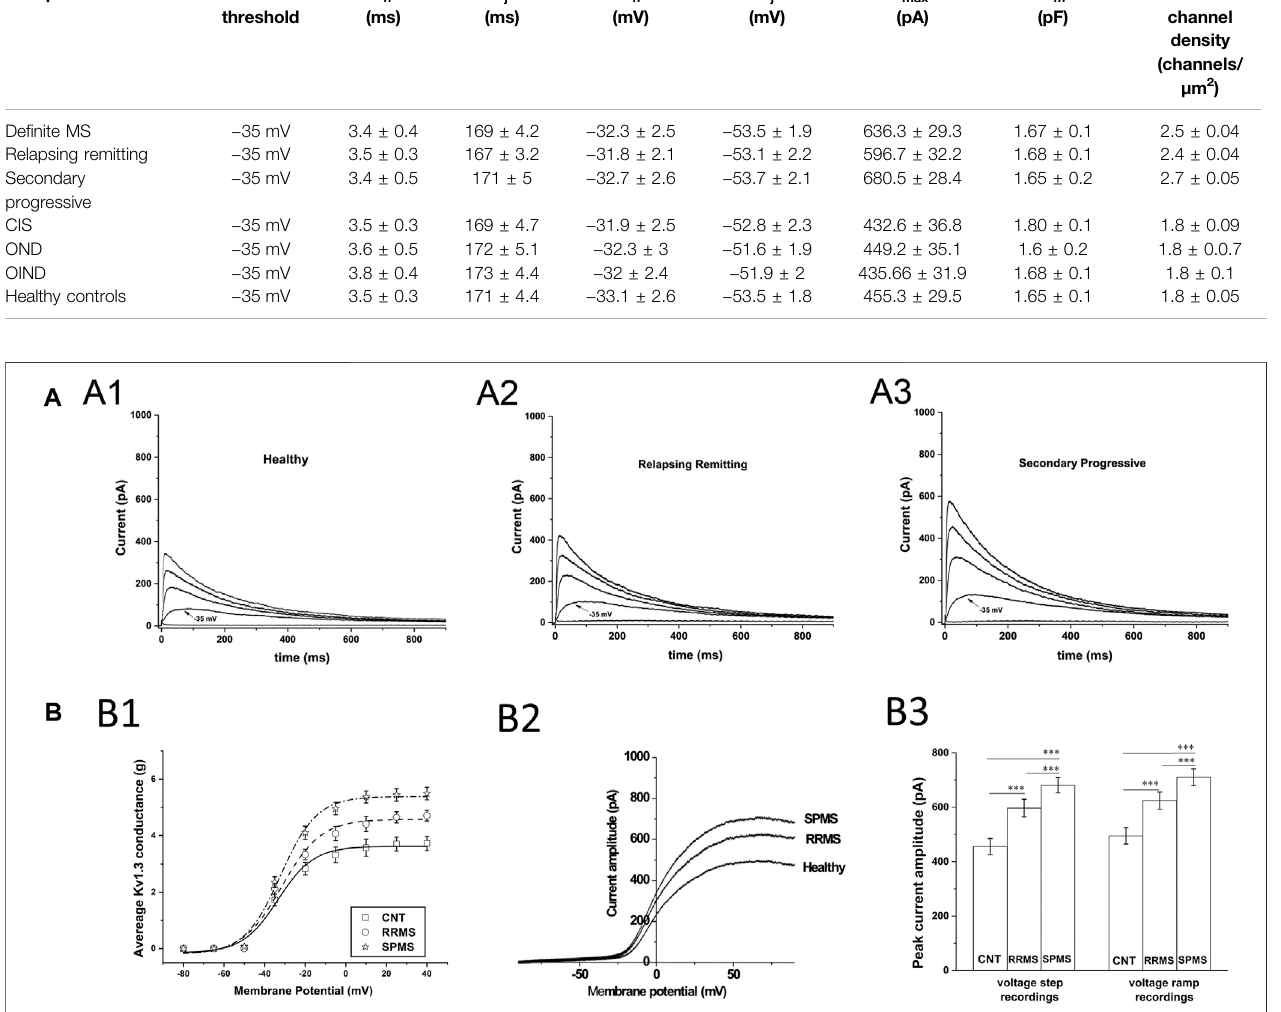
FIGURE1| PatchclampdatafromTcellsofMSpatientsandhealthycontrols. (A) :HighercurrentresponsesinMSTcells.Whole-cellcurrentsfromTlymphocytes bathed in extracellular solution of pH 7.4 with their membrane clamped at − 90 mV. MS T cells (N (cid:1) 855) have higher peak K V 1.3 amplitudes than controls (N (cid:1) 1,258). (A1 – A3): RepresentativeK V 1.3currentselicitedby1000-msdepolarizingpulsesin15-mVincrements,givenevery60 saredisplayedatphysiologicallyrelevantpotentials( − 50to+10 mV) for reasonsofclarity. (B) :T cellKv1.3currentsinSPMShavesigni fi cantly highermean peak amplitudesthan bothRRMSand healthy controls. (B1) : Increased peak Kv1.3 conductance,inMSpatientscomparedtohealthyindividuals.Peakcurrentamplitudesinresponsetovoltagestepprotocolswereconvertedtoconductance(g)values,averaged andplottedagainstthecorrespondingvoltageforSPMS(*),RRMS( ○ )andhealthycontrols( □ )(g-Vcurves).Theaveragemaximalpeakconductancewas5.49 ±